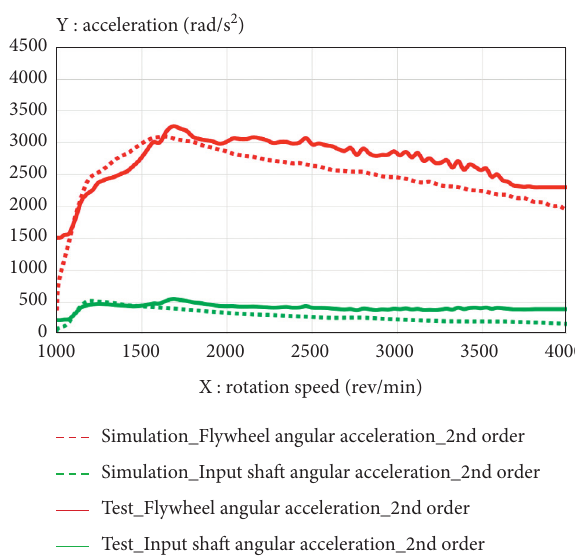
Figure 17: Simulated versus experimental DMF performance.